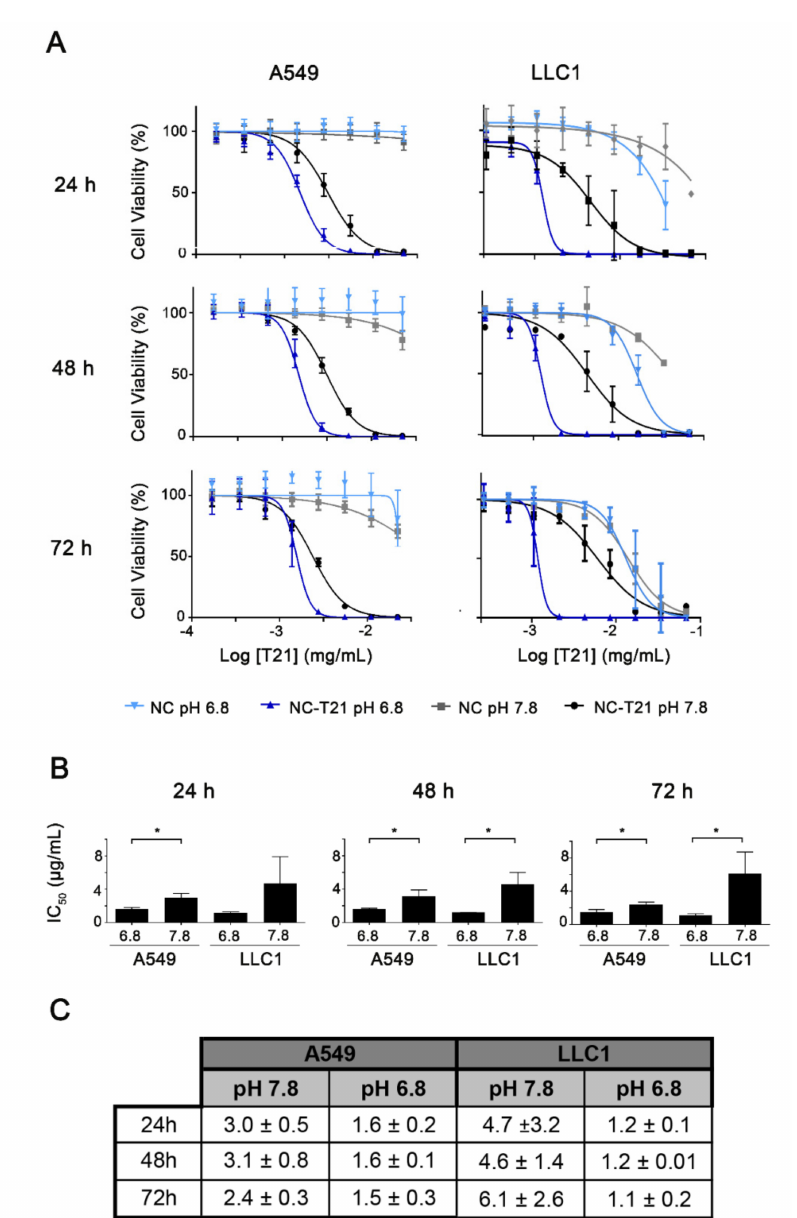
Figure 4. Study of cell viability after NC-T21 treatment dependent on pH. A549 and LLC1 cells were incubated with increasing concentrations of encapsulated T21 (NC-T21) or empty nanocapsules (NC) at pH 6.8 (blue) or 7.8 (black and grey) for 24, 48, and 72 h. ( A ). Cell viability was measured by tripli- cated MTT assay obtaining cell viability curves where IC 50 value was extrapolated. ( B ) Comparison of the IC 50 values. * p < 0.05. ( C ) IC 50 values ( µ g/mL ± SD), obtained from dose-response